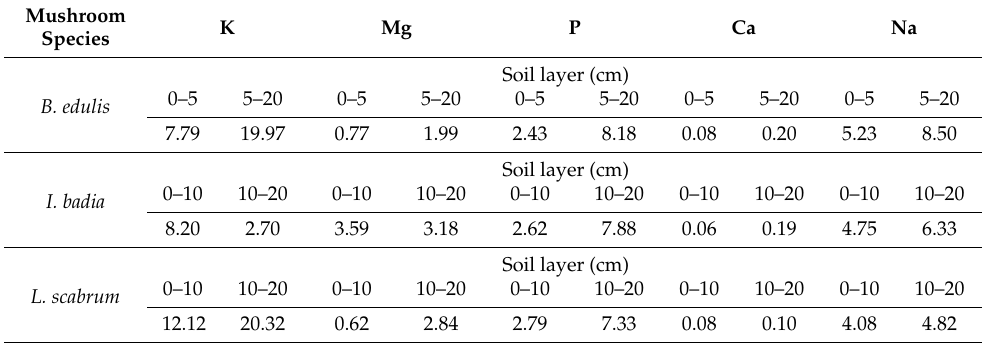
Table 4. Bioconcentration factors of macronutrients in